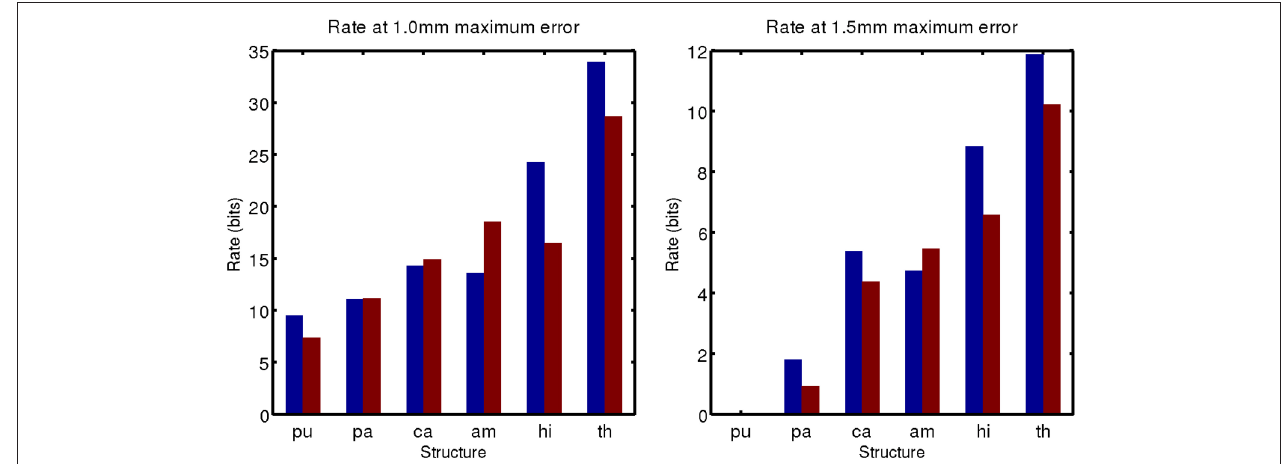
FIGURE 9 | Code rate required for 1 mm (Left) and 1.5 mm (Right) geometric error.